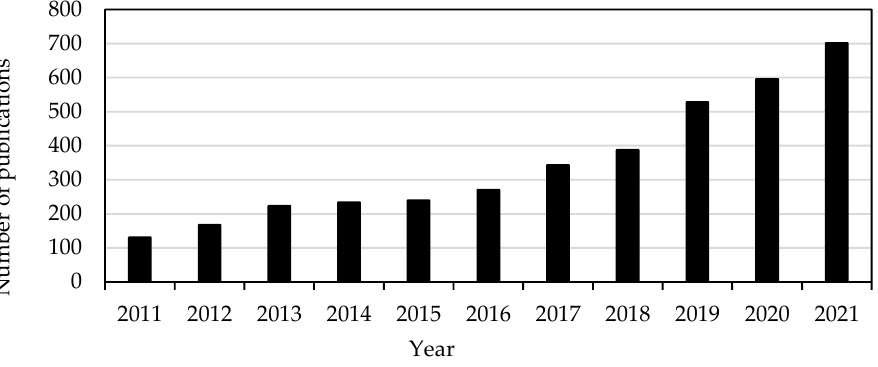
Figure 1. The number of publications on rolling bearing fault diagnosis from 2011 to 2021.